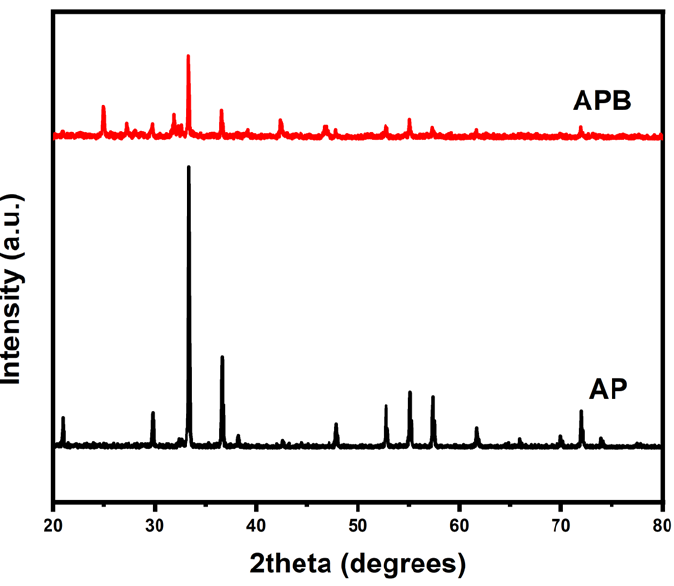
Figure 2. The powder X-ray diffraction patterns of pure Ag 3 PO 4 and BaO@Ag 3 PO 4 nanocomposite.